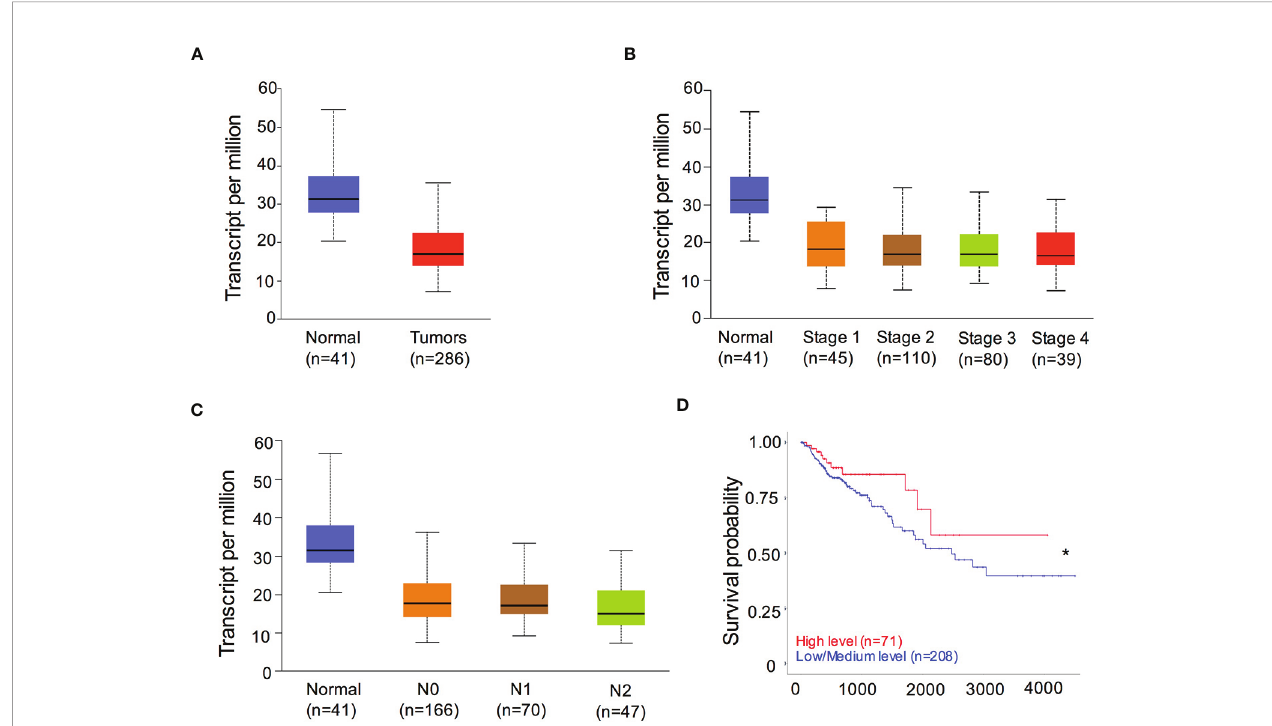
FIGURE 1 | RIPK3 expression is reduced in colorectal cancer (CRC) patients. (A) The levels of RIPK3 mRNA expression in colorectal cancer (CRC) and normal colorectal (NC) tissues in the TCGA colorectal database. n, sample numbers. (B) The levels of RIPK3 mRNA expression in different stages of CRC progression. (C) The levels of RIPK3 mRNA expression in metastatic tumors and normal counterparts. (D) Kaplan- Meier analyses of RIPK3 expression in colorectal cancer patients. * p <